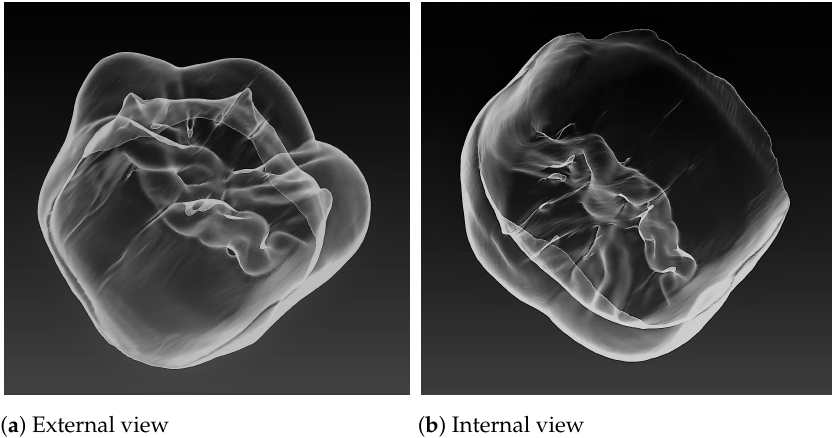
Figure 2. Enamel cap 3D reconstruction in a semi-transparent visualization mode; lower left first molar, S2: external view ( a ) and internal view ( b